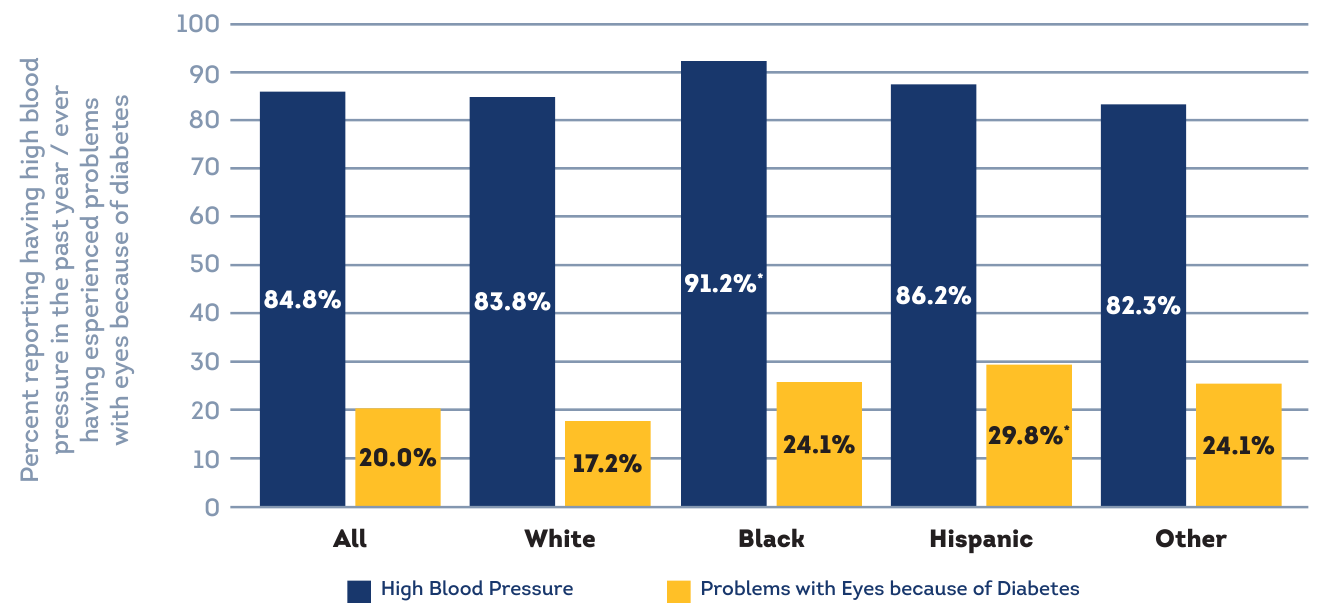
Figure 8. Percentage reporting high blood pressure in the past year or ever having experienced diabetes-related eye problems, among community-dwelling Medicare beneficiaries with self-reported diagnosed diabetes, by race/ethnicity